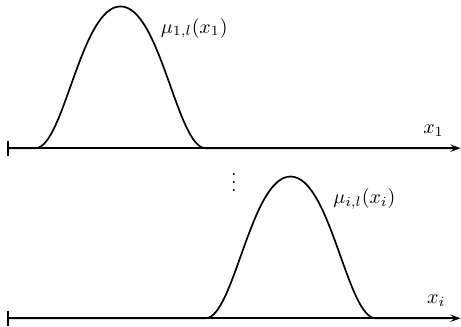
Figure 16. Gaussian sets for each input.